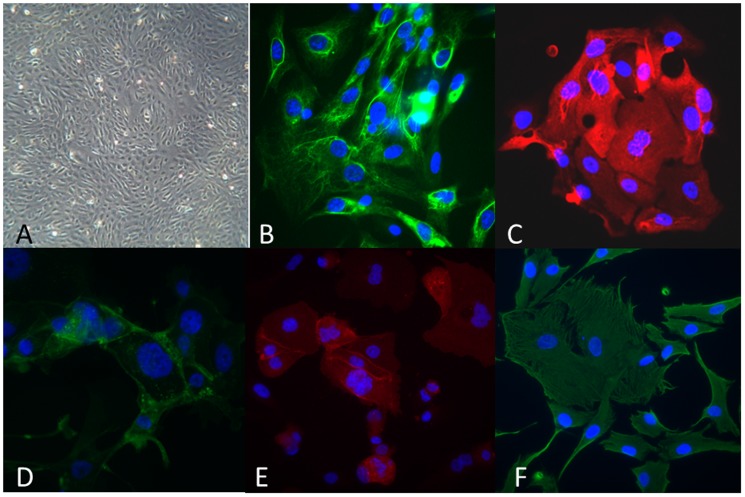
Phenotypic appearances of primary cultures.A: Brightfield demonstrating cobblestone monolayer; immunoflourescent images with antibodies targeted against: B: FITC-anti-pancytokeratin; C: Alexafluor 596 anti-CA125; D: Alexflour 488 anti-EpCAM; E: Alexafluor 596 anti-MOC 31; F: Alexaflour 596 anti-Vimentin